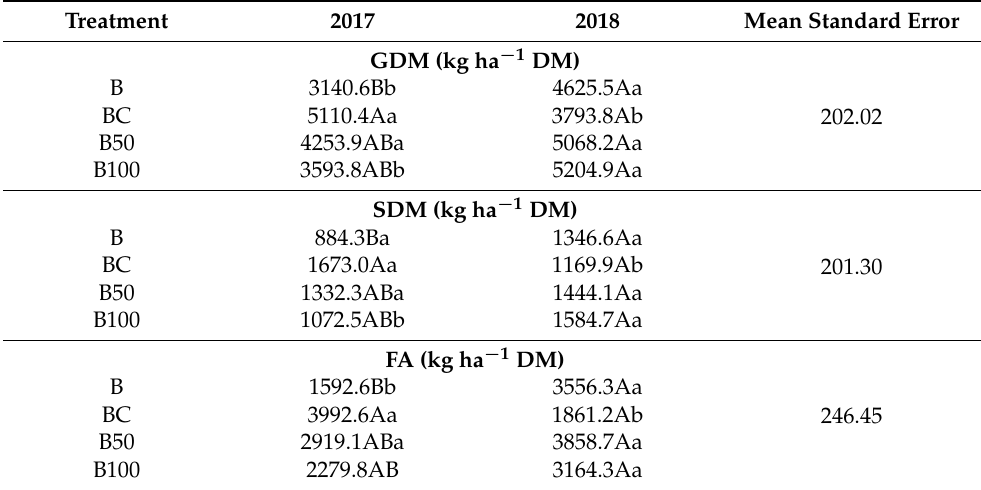
Table 3. Averages of green dry mass (GDM), stem dry mass (SDM), and forage accumulation (FA) for the different treatments and experimental years at the end of the deferral